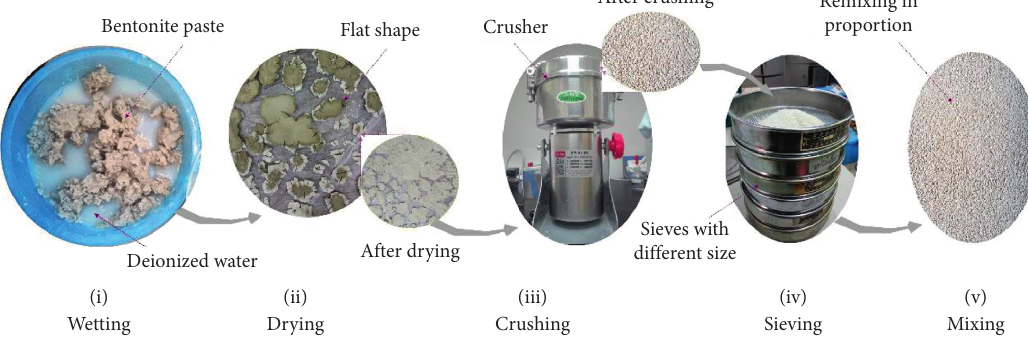
Figure 2: The fabrication process of bentonite